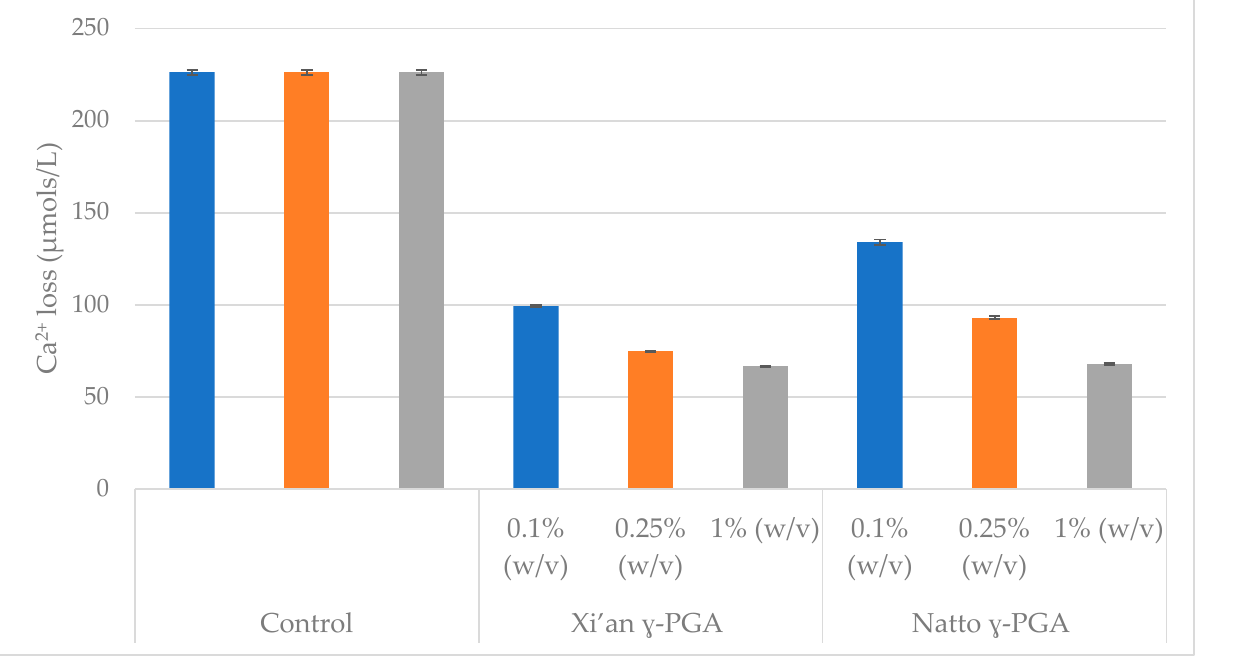
Figure 6. Comparison of the ISE pilot study result showing the Ca 2+ activity from HAp disc (20% porous) protected by different commercial γ -PGAs at 0.1, 0.25 and 1% ( w / v ). n = 3. Error bars indicate standard error